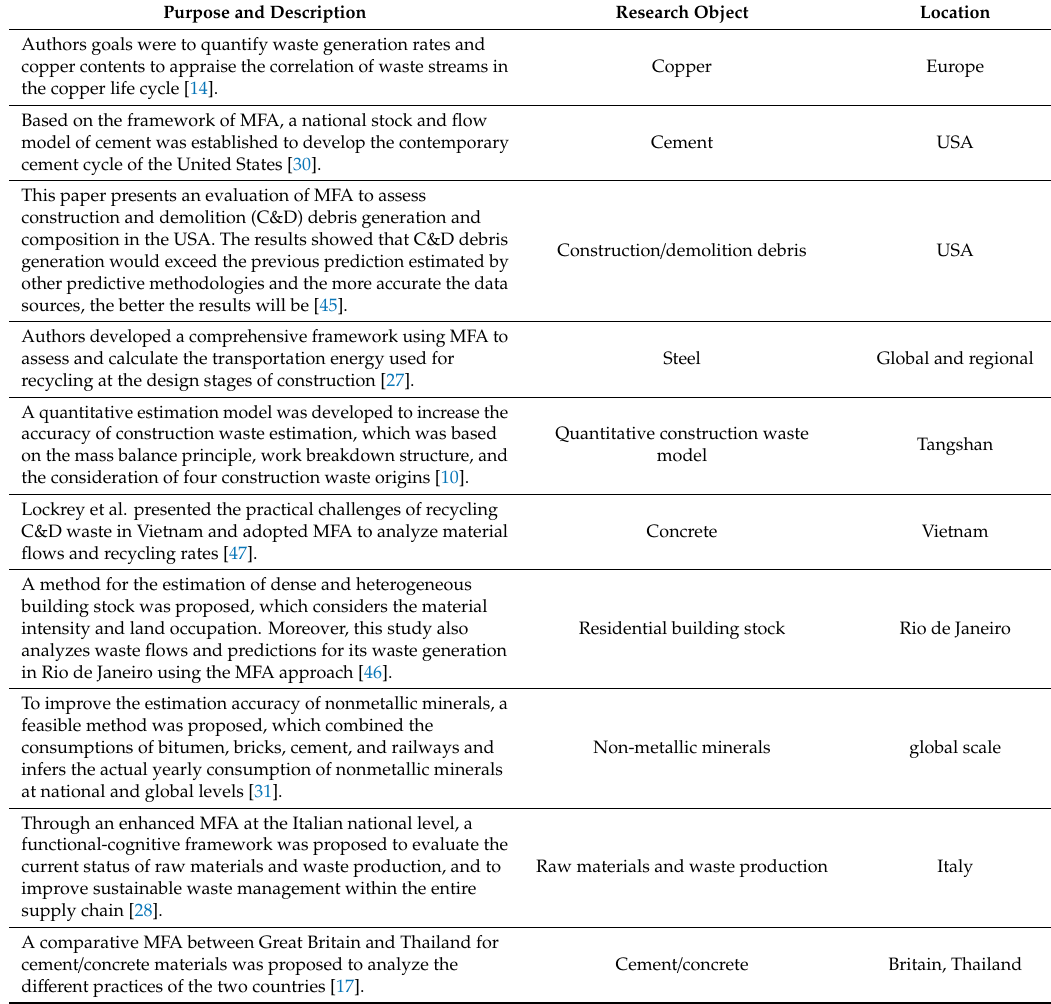
Table 2. Summary and analysis of C&D waste processing based on traditional